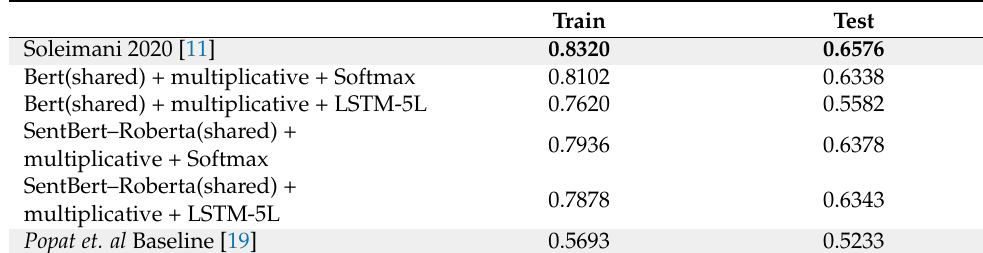
Table 3. Accuracy of the best configurations. Relevance evaluation task.